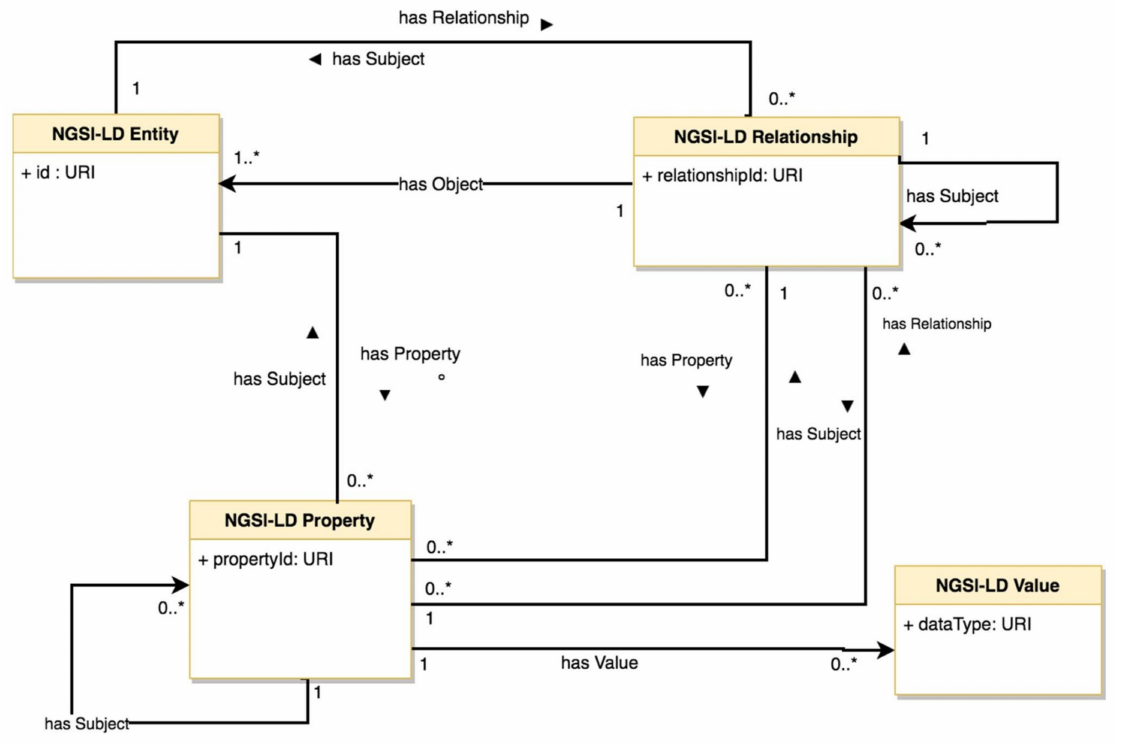
Figure 5. UML representation of ETSI ISG CIM (NGSI-LD) information model